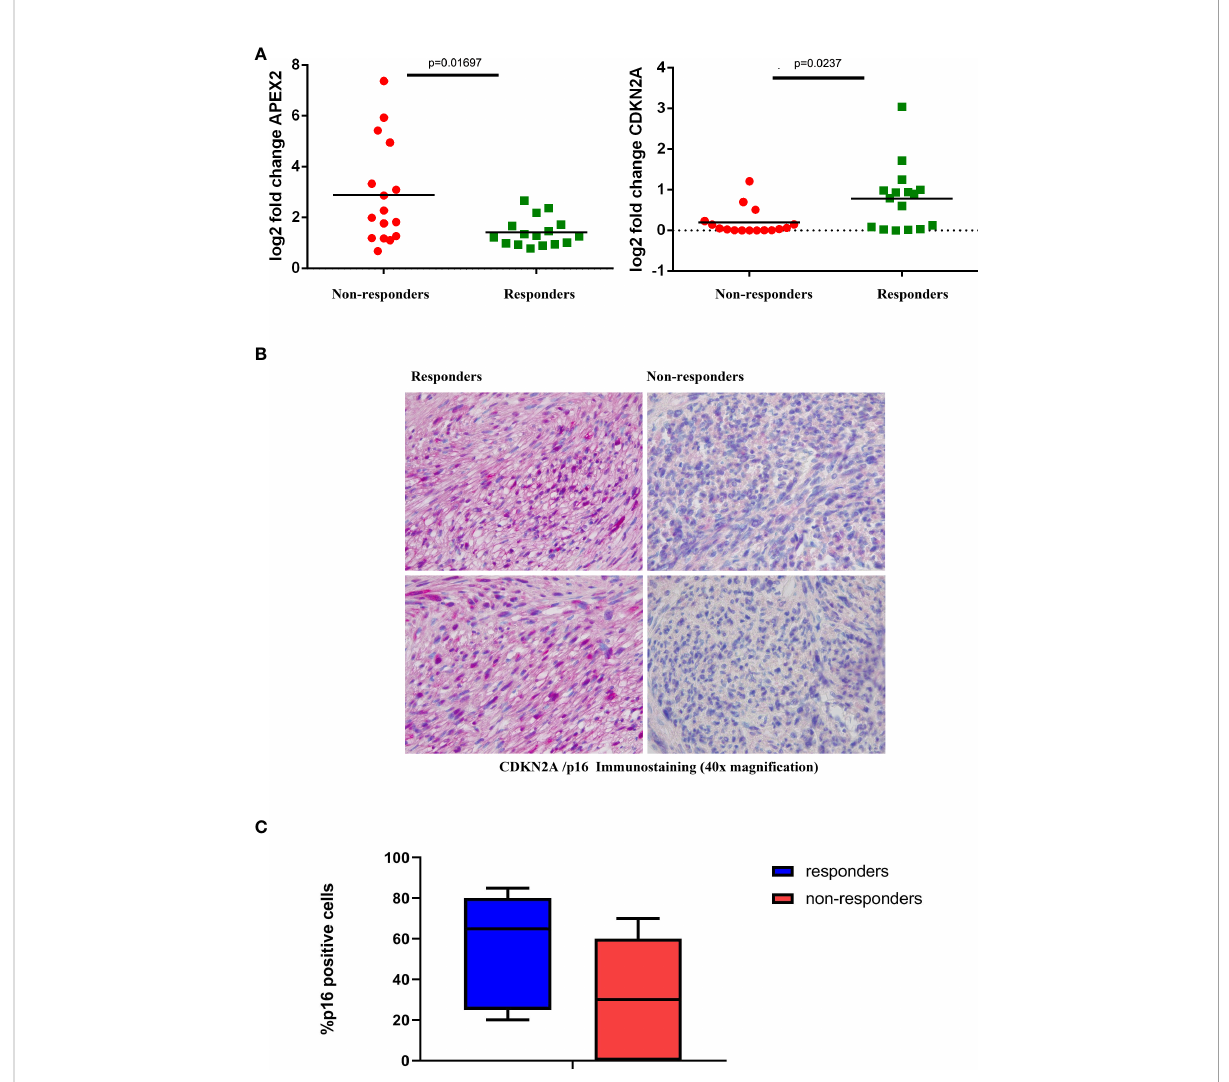
FIGURE 3 Validation Assays (A) Expression levels of representative genes (CDKN2A, left; and APEX2, right) among responder and non-responder patients. Statistically signi fi cant differential expression was shown between the two groups (Wilcoxon rank-sum test). (B) Representative IHC staining of CDKN2A/p16 in tumor samples from responder and non-responder patients. (C) Box plot distribution of CDKN2a/p16 expression level (percentage of IHC positive cells) in responders and non-responders